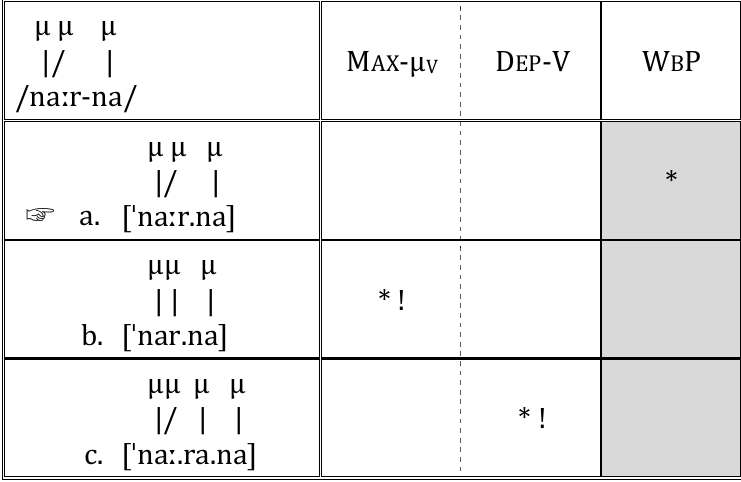
Tableau 5 : Since W B P is ranked low, the fully faithful candidate is allowed to surface, and neither epenthesis nor vocalic mora deletion